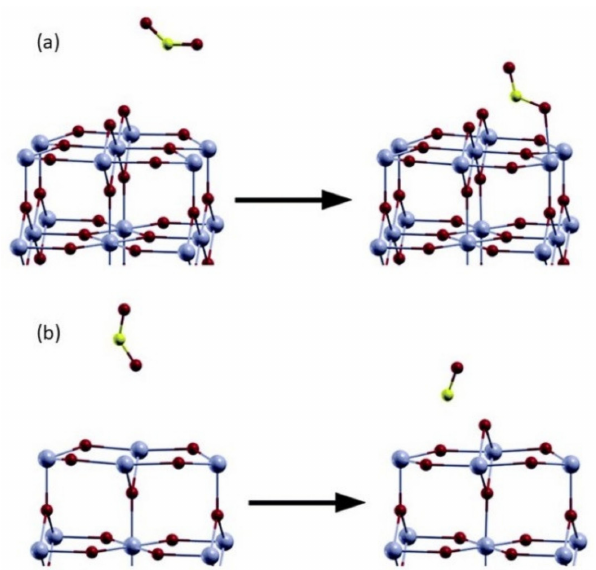
Figure 12. Adsorption of NO 2 onto (110) surface of SnO 2 . ( a ) Stoichiometric surface, monodentate adsorption onto Sn 5c . ( b ) Reduced surface, dissociative adsorption onto a V br , leading to the healing of the vacancy and an adsorbed NO molecule. Reproduced with permission from Reference